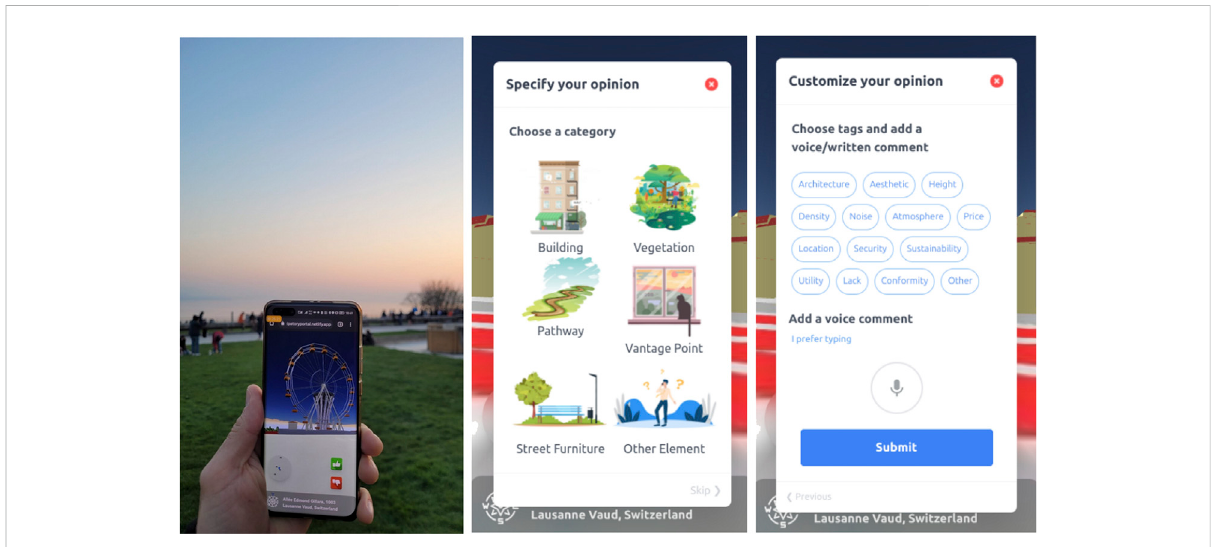
FIGURE 2 Presentation of the screen of the web application implementing the concept of guerrilla e-participation. From left to right: a picture of a participant using the app in situ and observing the current layout of the public space with the future project; fi rst screen where the participants have to choose a category for their positive/negative tagged object; second screen where participants can develop their observation with tags and comments before